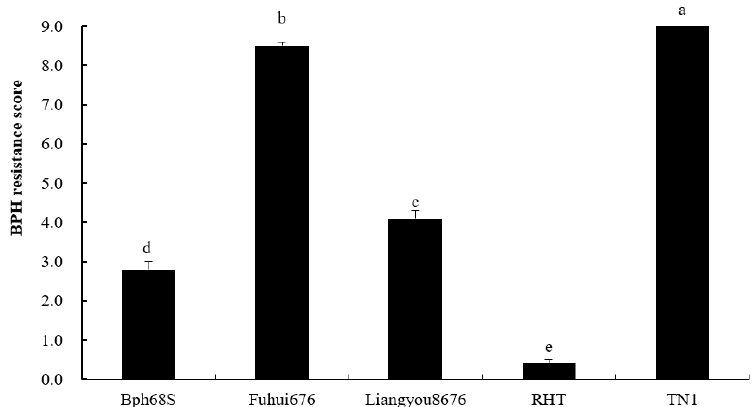
Figure 1. BPH resistance scores of rice lines. Error bars indicate standard deviation. And bars labeled with different letters indicate significant difference ( p < 0.05, one-way ANOVA, LSD multiple comparison).